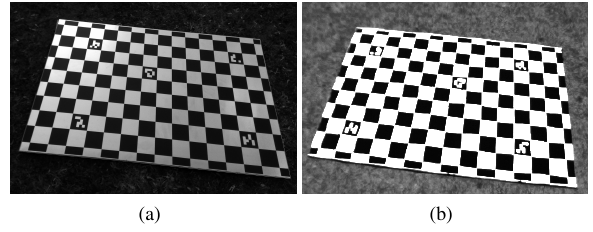
Figure 6. Improved chessboard with higher thermal contrast and larger patterns (a) VIS (b) inverted LWIR image (dark tones mean cooler